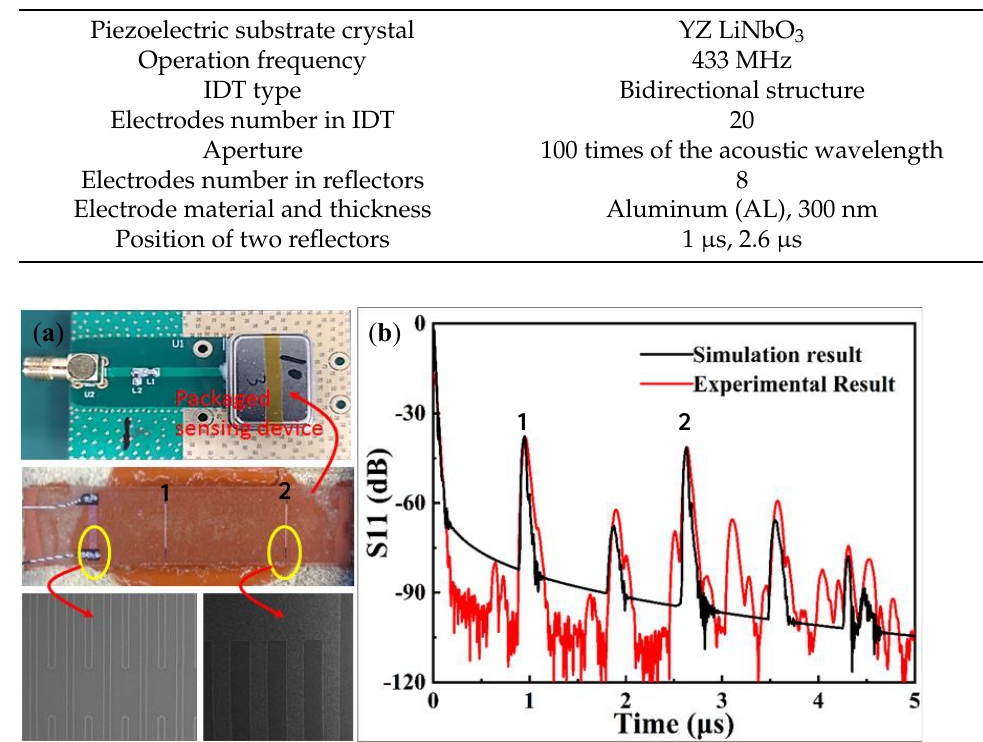
Figure 2. ( a ) Developed SAW sensing device, ( b ) measured and simulated S 11 of proposed SAW